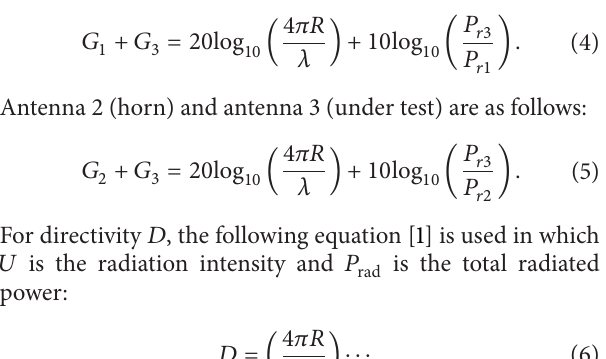
Figure 14: PCB prototyping machine (LPKF S63).